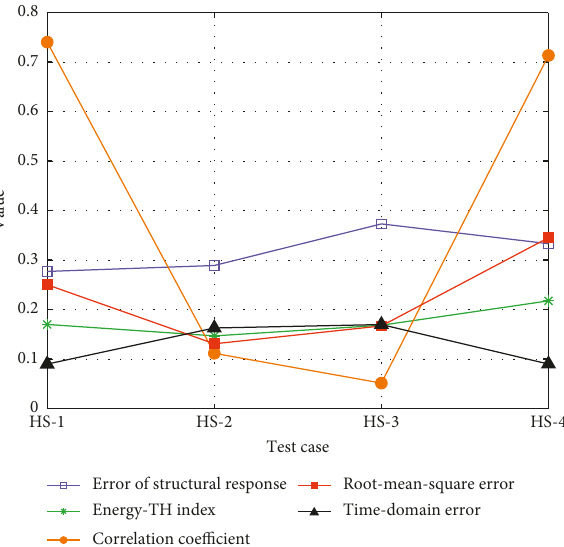
Figure 27: Comparison between structural response overall error and other indices of test HS.